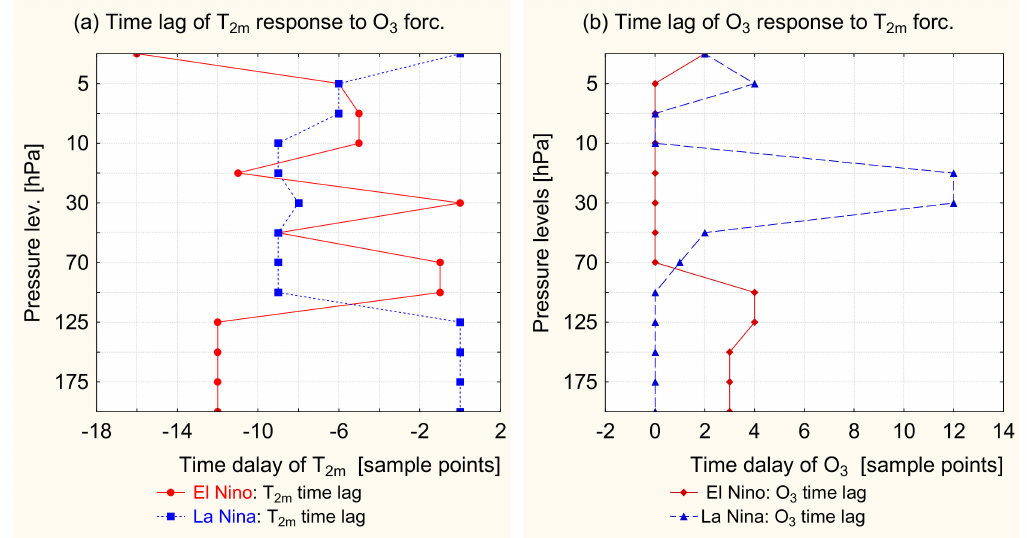
Figure 9. Time delay of the near surface temperature (T 2m ) response to ozone changes ( a ), together with the ozone response to the T 2m forcing ( b ), in relative records’ units of